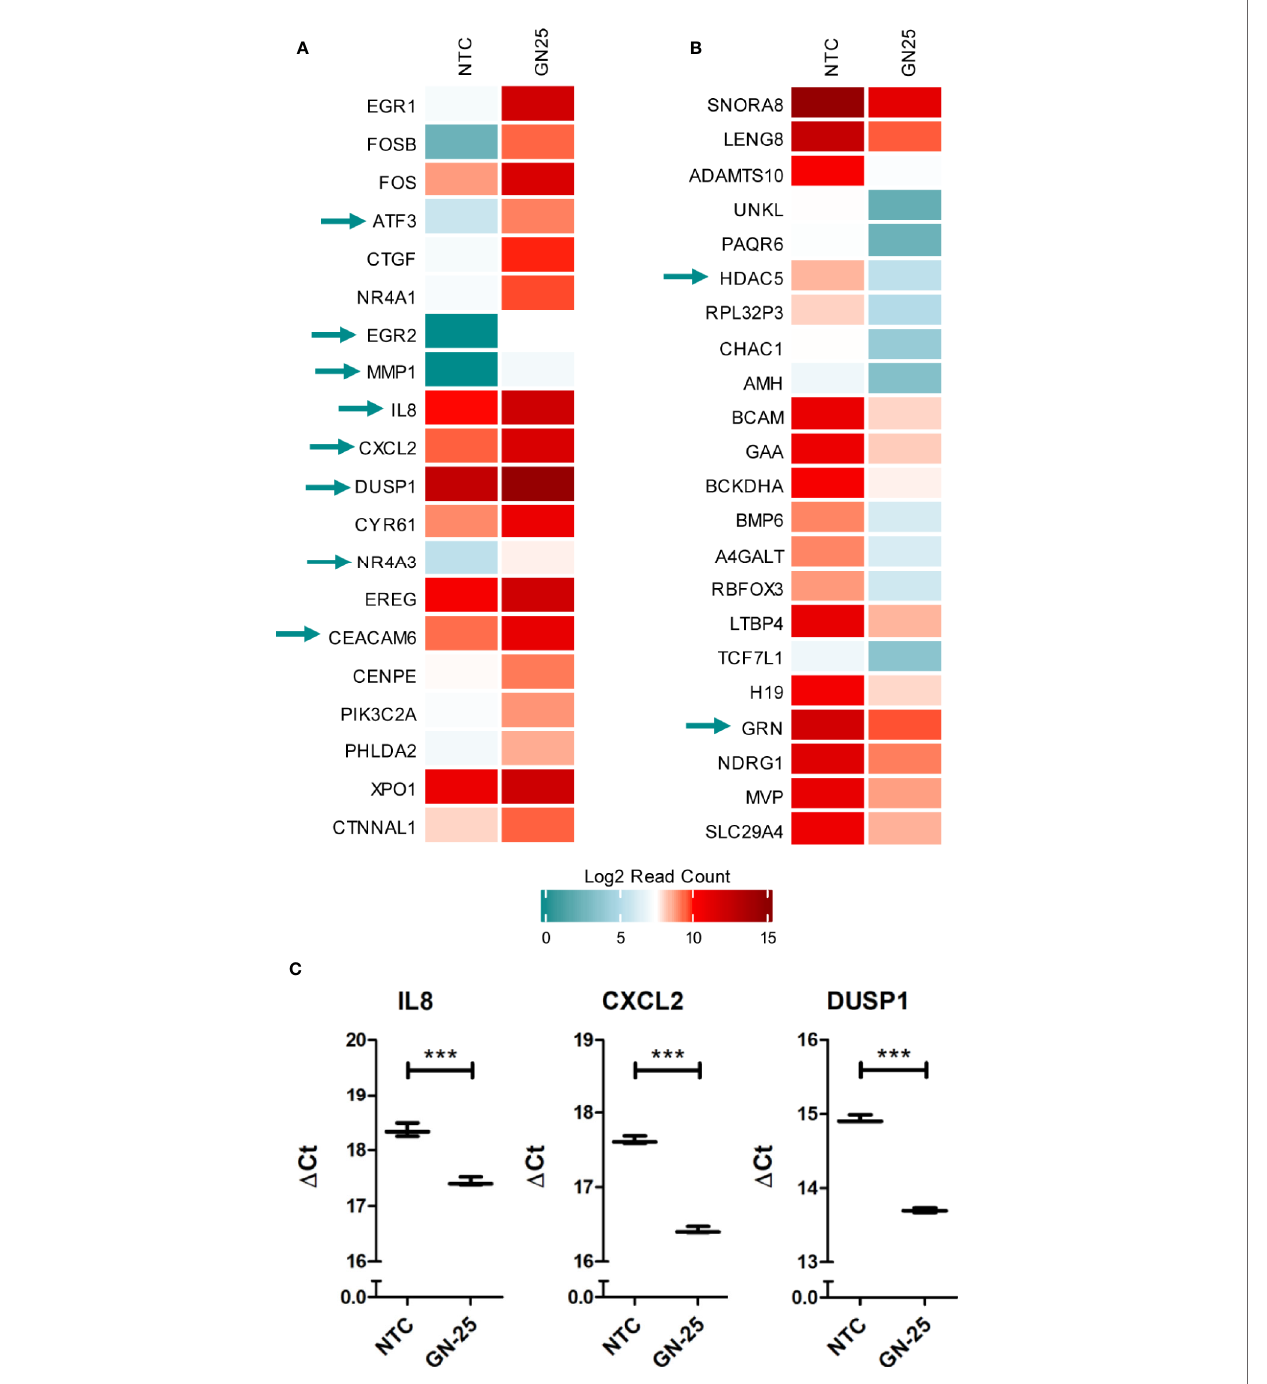
FIGURE 5 | Immune genes enrichment in the top differentially expressed genes. heatmap representation of the log2 Read counts of the (A) top 20 upregulated genes and the (B) top 20 downregulated genes in GN25 treated cells in comparison to the vehicle negative control. Green arrows indicate genes that intersect with the differentially expressed genes enriched in the immune gene ontology gene sets (C) . Gene expression validation using qRT-PCR of immune response genes identi fi ed in the RNA-seq analysis including IL8, CXCL2, and DUSP1. *** represents p-value